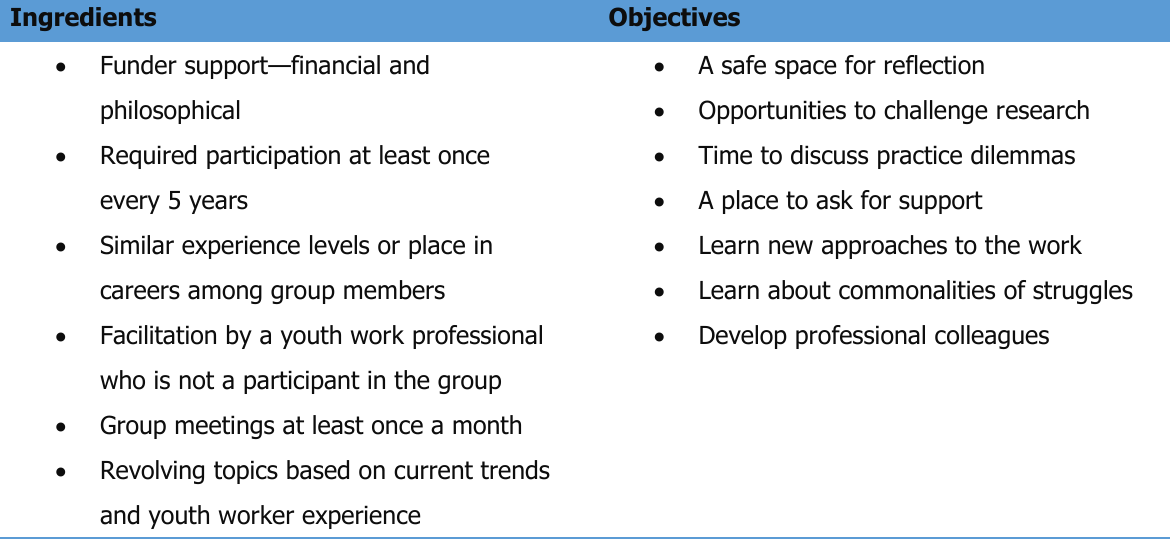
Figure 1. Key Ingredients and Objectives for a Basic Reflection Model